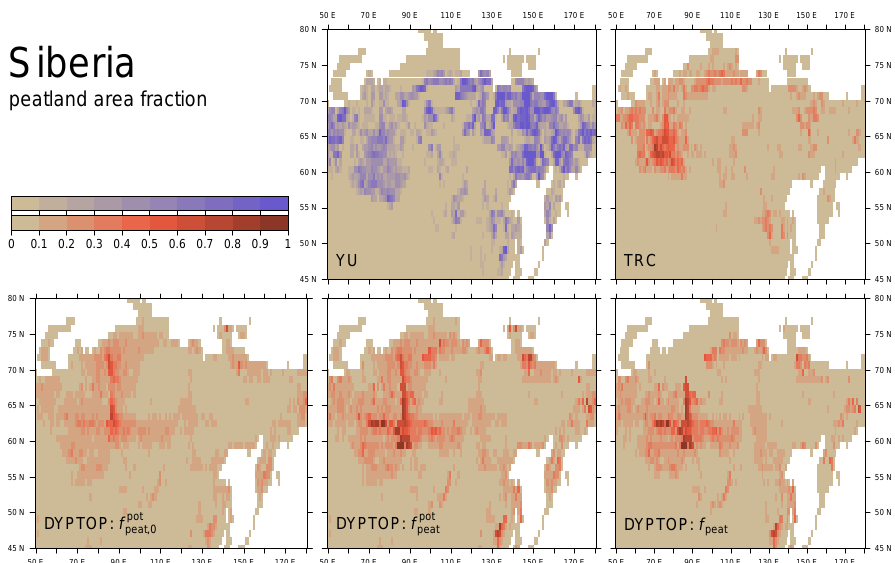
Figure 9. Observed and simulated peatland area fraction in Siberia. Top row: observed, YU is based on Yu et al. (2010), TRC is based on Tarnocai et al. (2009). Original YU data delineate grid cells with a significant peatland cover fraction ( > 5%). Original binary data on 0.05 ◦ × 0.05 ◦ are regridded to represent the fractional area with significant peatland cover fraction on the 1 ◦ × 1 ◦ grid. This information is not directly comparable to other panels and is therefore illustrated with a distinct colour key. Bottom row: simulated, f pot peatland area fraction, considering hydrological suitability without the peatland water table position feedback, f pot peat is the potential peatland area fraction, considering hydrological suitability including the peatland water table position feedback. f peat is the simulated actual peatland area fraction, taking account of the peatland establishment criteria (pt crit ) and peat expansion and contraction.